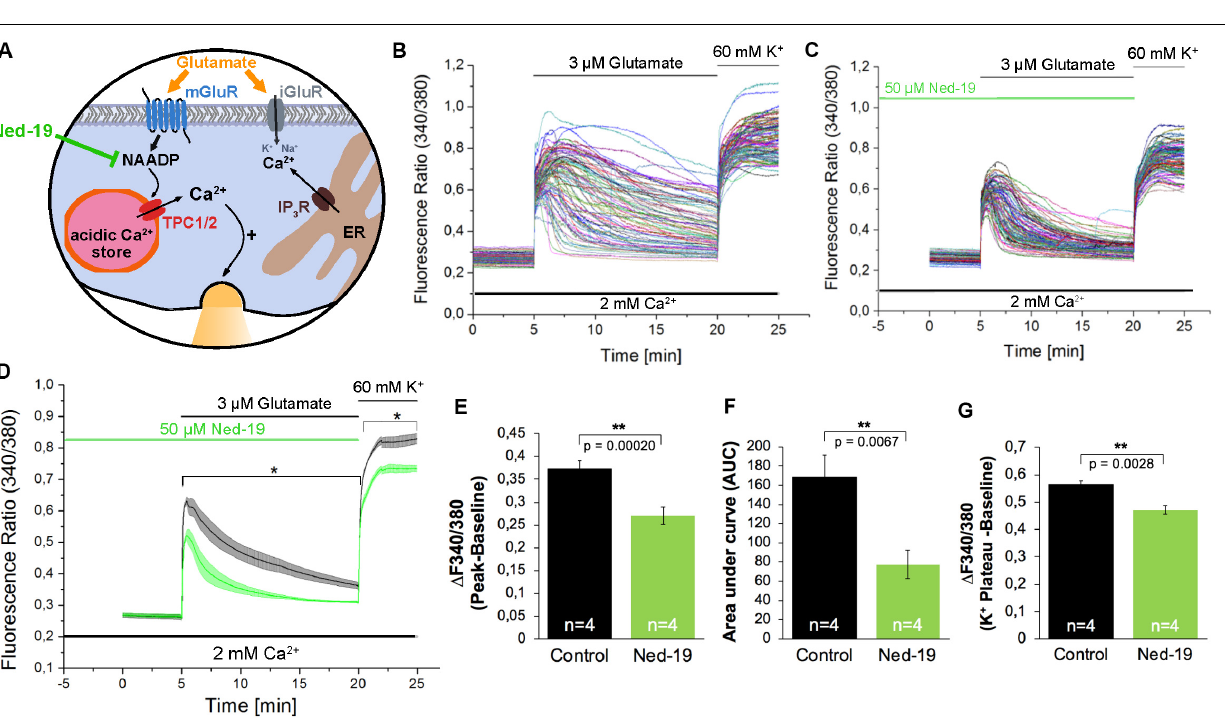
FIGURE 2 | The NAADP antagonist Ned-19 reduces the glutamate-induced Ca 2 + increase in hippocampal neurons. (A) Ned-19 acts as a NAADP antagonist (Naylor et al., 2009). (B,C) Representative traces of the glutamate-induced changes in the F340/380 fluorescence intensity values in hippocampal neurons without (B) and with (C) pretreatment with Ned-19 (50 µ M). (D) Average traces are given as the arithmetic mean ± SEM of the F340/380 fluorescence intensity values without (black, n = 1057 cells) and with (green, n = 659 cells) Ned-19 (50 µ M) pre-incubation. Data from four independent C57Bl/6N preparations ( N = 4) are shown. During all experiments, the cells were remained in physiological solution containing 2 mM Ca 2 + . For measurements with Ned19, the cells were pre-incubated for 5 min. After 5 min of baseline recording, the cells were stimulated with glutamate (3 µ M) for 15 min. For the last 5 min, the cells were stimulated with high potassium solution (60 mM K + ). The amplitude of the glutamate-induced calcium increase (E) as well as the AUC (F) and the amplitude of the high-potassium induced calcium transients (G) were analyzed. **: p < 0,01; *: p <